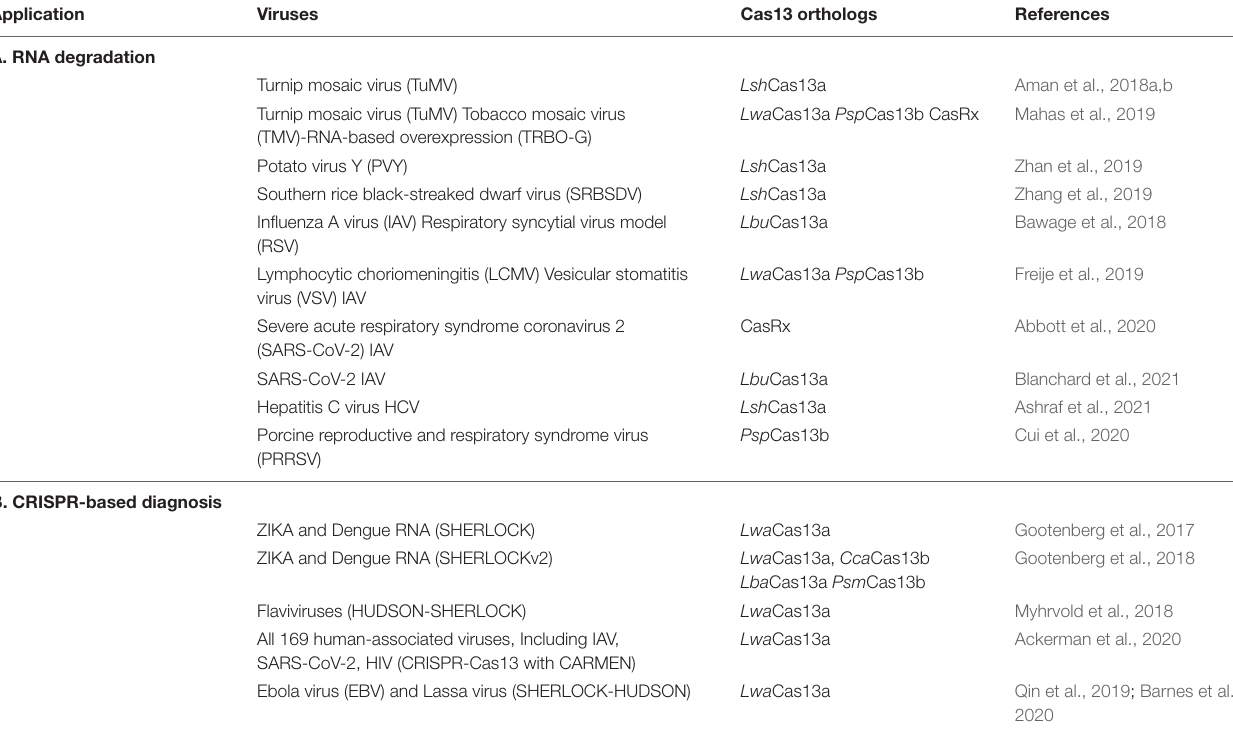
TABLE 1 | Summary of the Cas13 effectors and their applications for viral RNA degradation and CRISPR-based